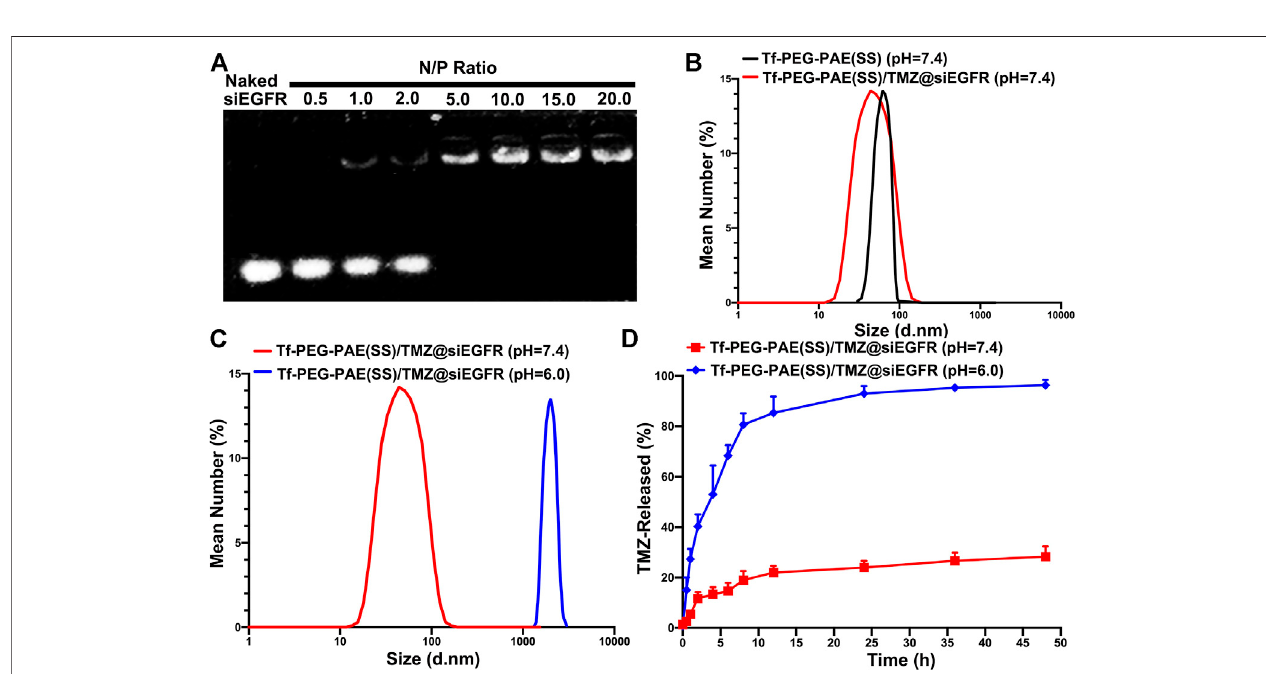
FIGURE3| CharacterizationofthepH-sensitiveTf-PEG-PAE(SS)/TMZ@siEGFR. (A) siEGFRbindingabilityatnumerousN/Pratios. (B – C) AveragesizeofTf-PEG- PAE(SS)andTf-PEG-PAE(SS)/TMZ@siEGFRatpH7.4andpH6.0. (D) Invitro drugreleaseofTf-PEG-PAE(SS)/TMZ@siEGFRatpH7.4andpH6.0(Mean±SD,n=3).